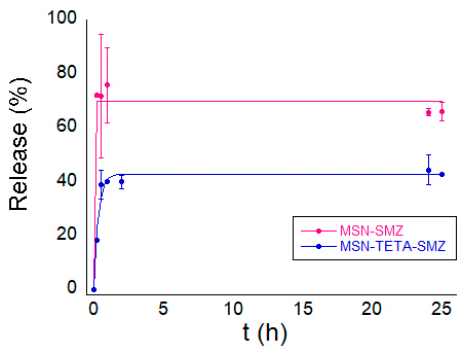
Figure 7. In vitro SMZ release of MSN and MSN-TETA . Table 4. Kinetic parameters for SMZ release from MSN and MSN-TETA.